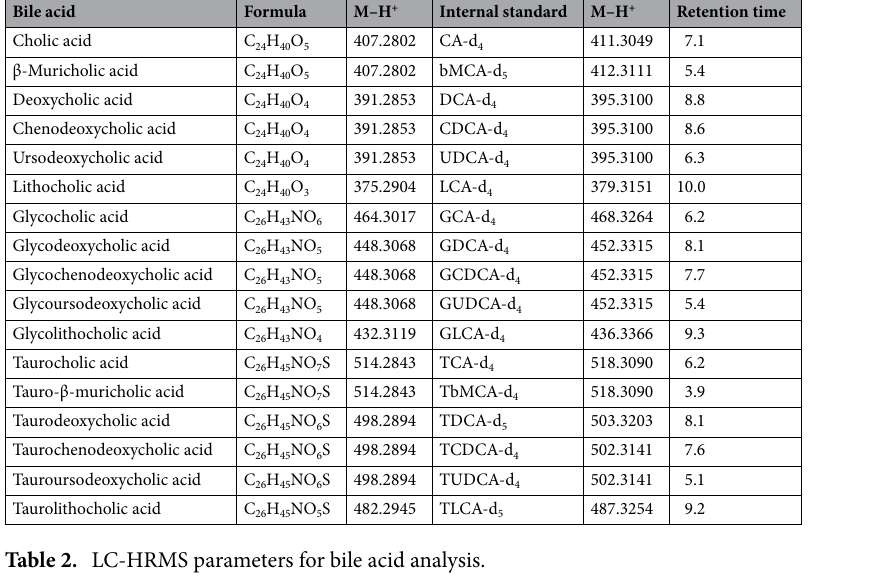
Table 2. LC-HRMS parameters for bile acid analysis.